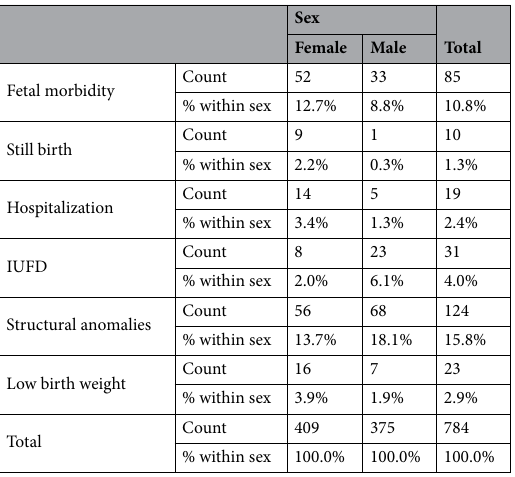
Table 5. Association between fetal sex and adverse fetal/maternal